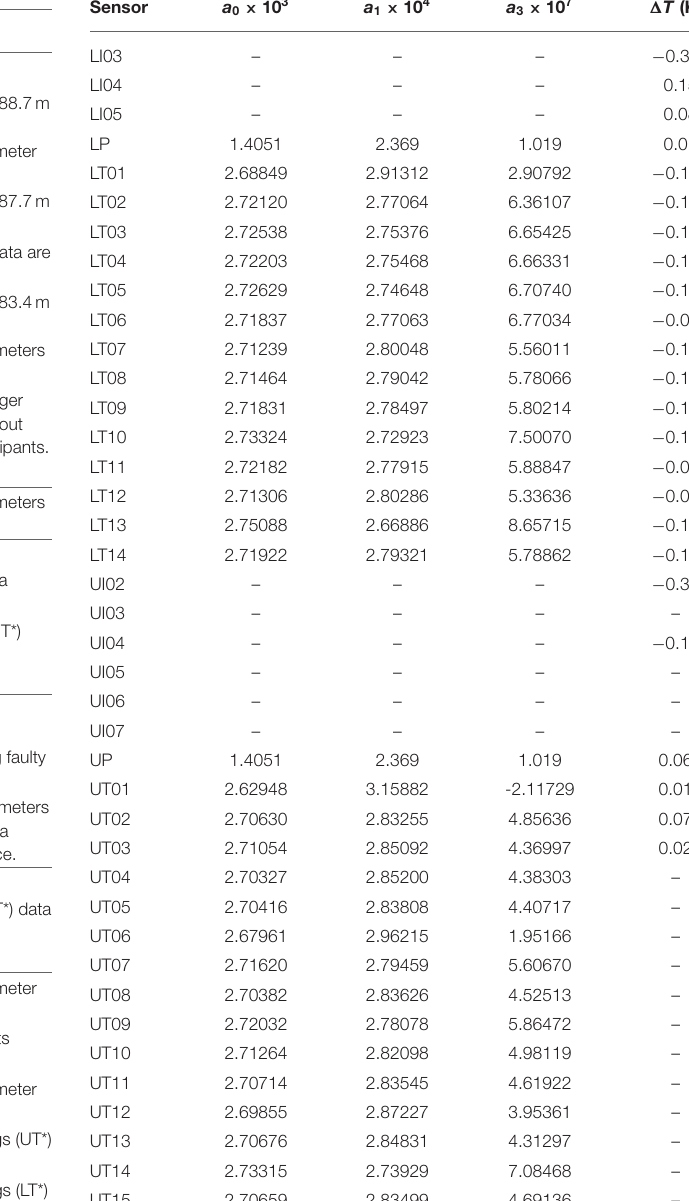
TABLE 1 | Timeline of events including borehole drilling locations and initial depths, instrumental failures, and final removal (dates as YYYY-MM-DD).